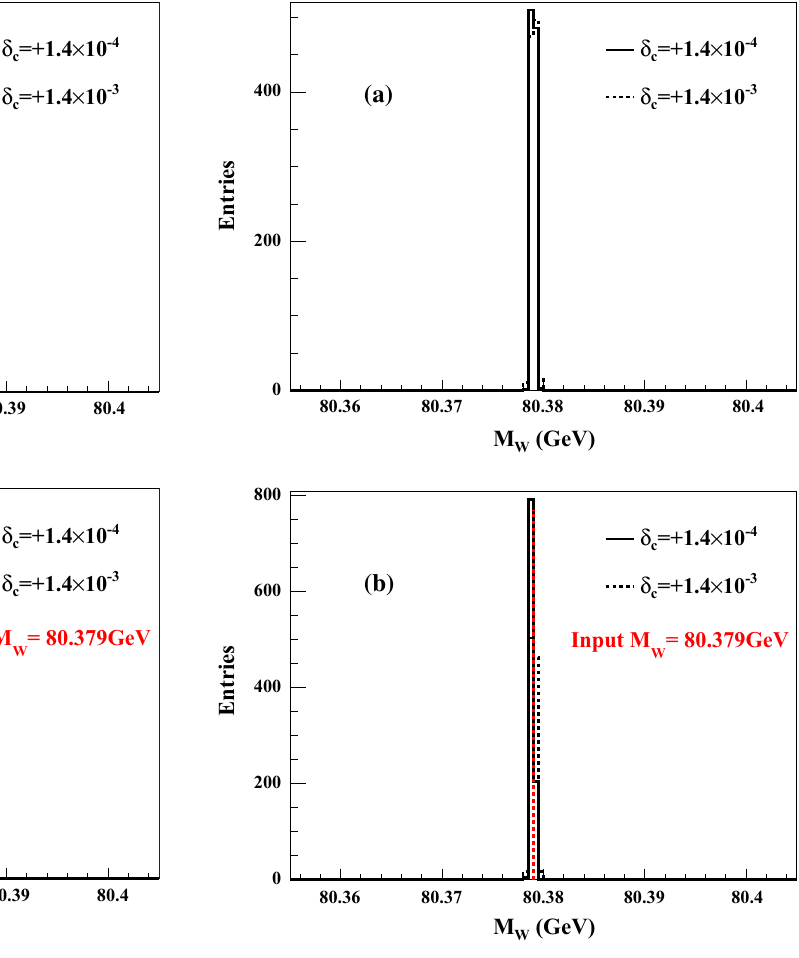
Fig. 9 The simulation results of m W for the Gaussian (a) and non- Gaussian (b) cases, the input m W is 80.379 GeV and the scale fac- tor method is used. The black solid and dash lines are the result for δ = + 1 . 4 · 10 − 4 and δ = + 1 . 4 · 10 − 3 at 161.2 GeV and 162.5 GeV, c c